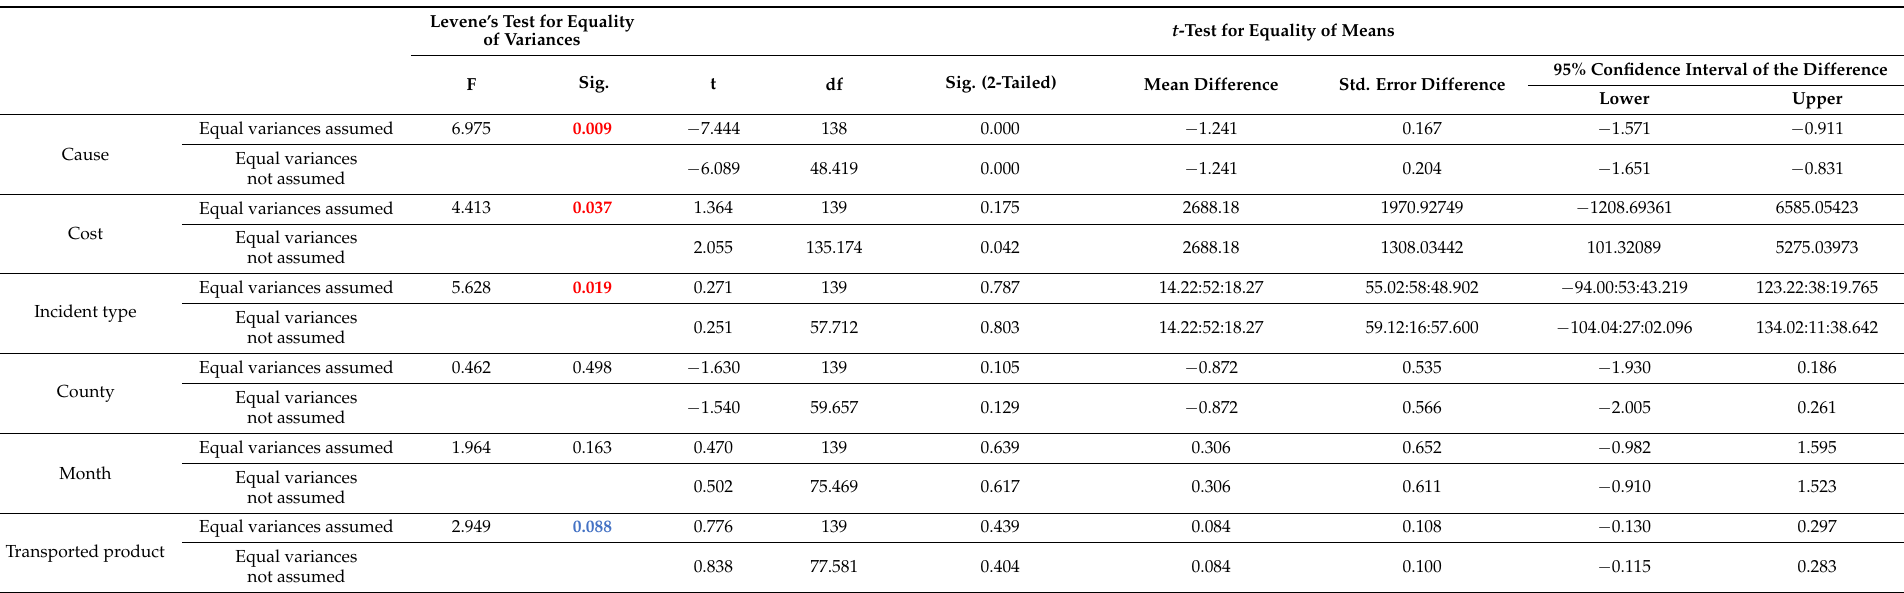
Table 22. Results for Student’s t